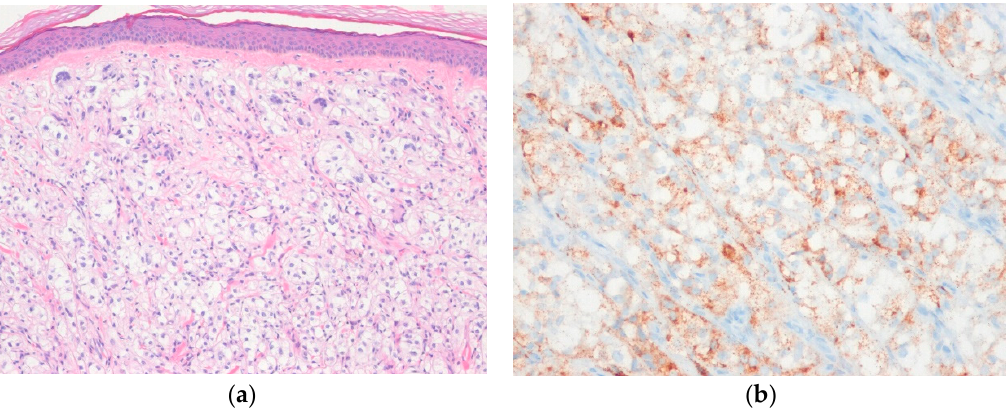
Figure 10. Cutaneous PEComa. ( a ) The tumor shows a nested architecture with epithelioid tumor cells containing abundant clear or granular eosinophilic cytoplasm; ( b ) The tumor cells are positive for HMB45 (H&E stain, original magnification 100× ( a ); HMB-45 immunostain, original magnification 200× ( b